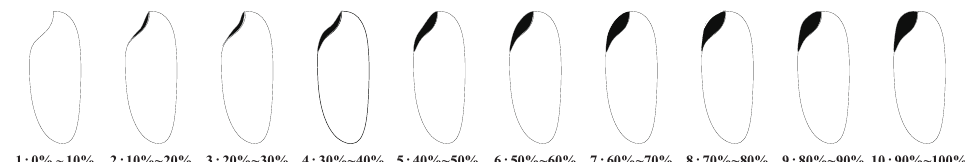
Figure 9. Ten kinds of rice with different germ integrity. The black area in the figure represents the rice germ part.